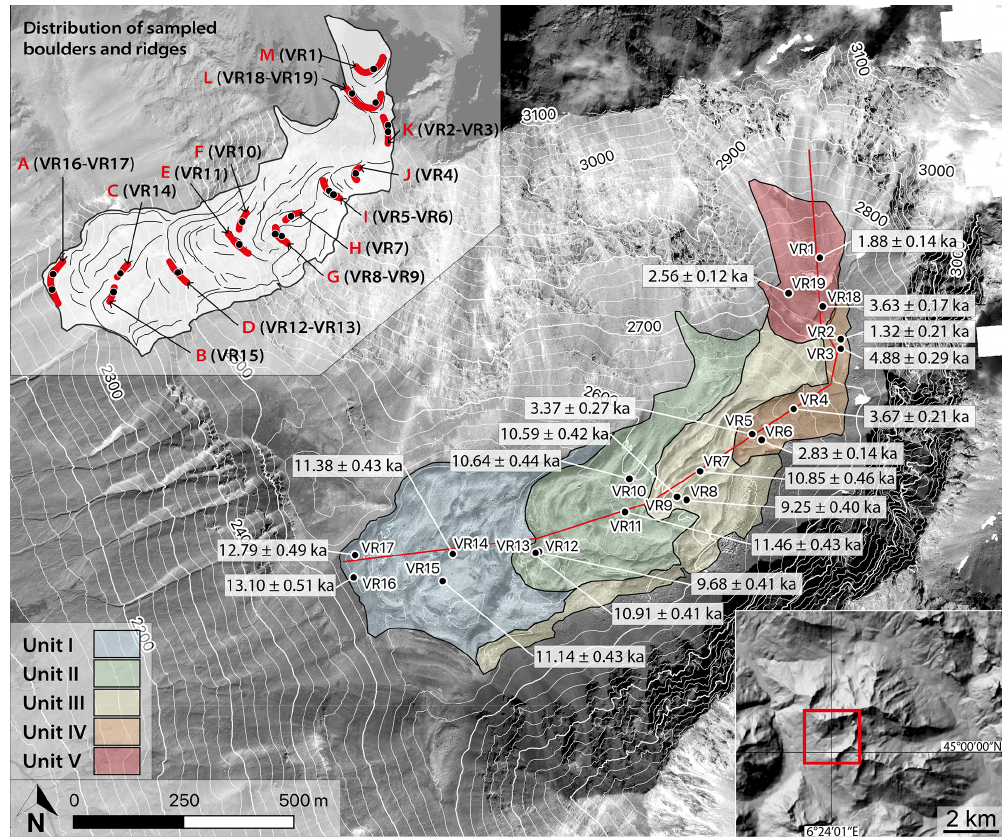
Figure 6. Map of the Vallon de la Route rock glacier, with units and sample locations. The hillshade DEM in the inset has been produced from a high-resolution lidar DSM (0.5m resolution) survey realized by SINTEGRA (17 August 2012); the white lines show elevation isolines derived from the same data. The red line is the longitudinal transect used to extract surface displacement (Fig. 5a). Individual 10 Be surface- exposure ages are shown with 1 standard deviation (Table 2). The lower-right inset shows the location of the study area within the Combeynot Massif (red box). The upper-left inset shows the samples (black dots) and ridges (red lines) distributed over the main furrow structures (black lines). The background is the orthomosaic of 2018 computed using a tri-stereo Pléaides 0.7m